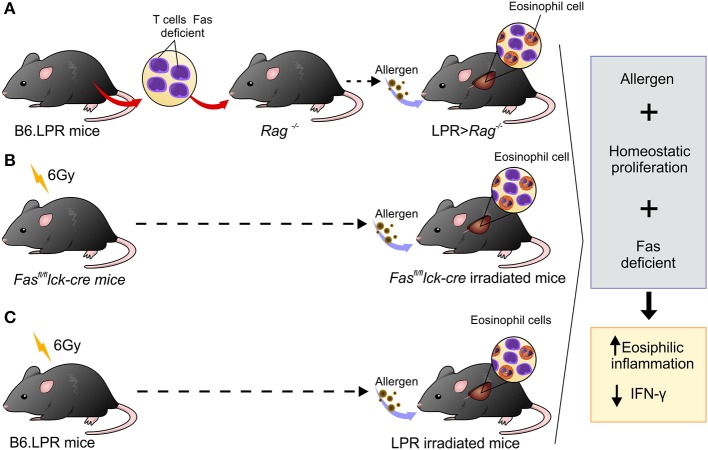
Schematic representation showing three different experimental designs leading to persistent eosinophilia in a mouse model. (A) B6.LPR T cells were adoptively transferred into Rag−/− mice, (B)
Fasfl/fl
lck-cre irradiated with 6 Gy and (C) B6.LPR irradiated with 6 Gy. All three situations involve transient lymphopenia, abnormal Fas-signaling, and antigen exposure resulting in decreasing levels of IFN-γ in the lung.